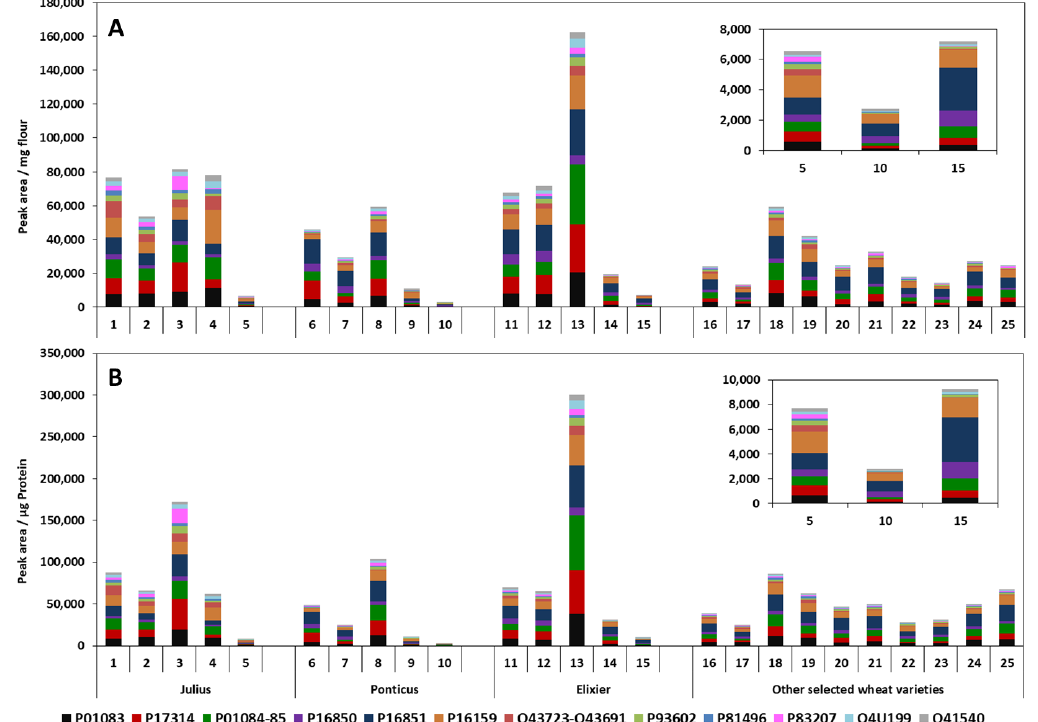
Figure 6. Distribution and relative abundance of ATIs from the German wheat cultivars presented as: ( A ) peak area obtained pro mg flour applied and ( B ) as peak area pro µg protein in the investigated CM extracts. Peak area was the response measured by the HPLC-MS/MS analysis for the quantifier peptide for the corresponding proteins. Side bar shows the sample allocation and the inset in each case shows the composition of the grain fraction “sling or spun bran”. 1–5; 6–10; and 11–15 represent the fractions whole-meal flour, centrifuged flour, passage flour, grain bran, and sling bran of the Julius , Ponticus, and Elixer cultivars, respectively. Samples 16 to 25 represent the extracts from A. Bayernkönig , Julius 2017 , RGT reform , Findus , Nordkap , Patras , Ponticus 2017 , Kerubino , Tobias, and Capo , respectively.